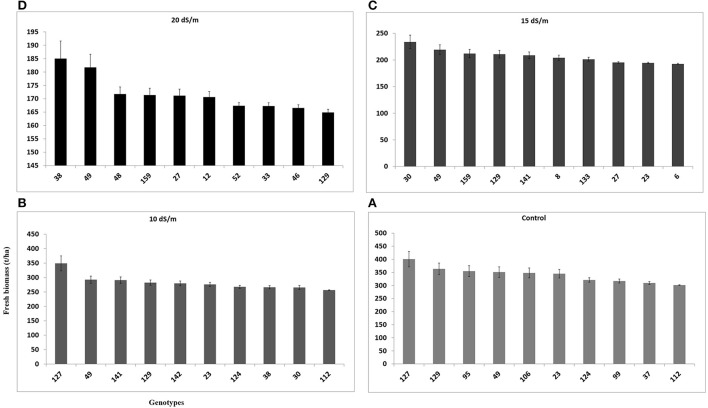
Effect of different irrigation water salinity levels on fresh biomass yield (total annual yield) of TOP 10 Cenchrus ciliaris genotypes. Error bars represent standard deviations of the mean of four replicates. Whereas, (A) = 0, (B) = 10, (C) = 15, and (D) = 20 dS m−1 salinity level.